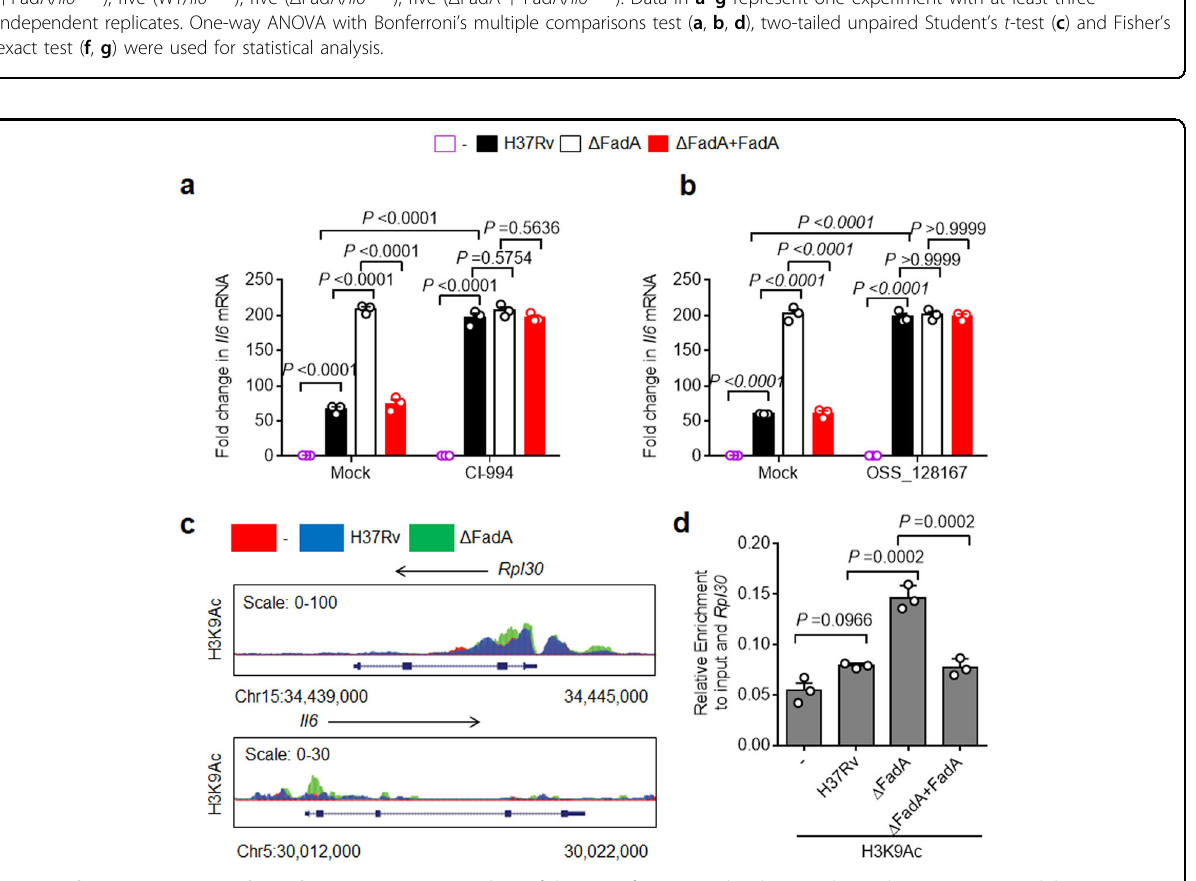
(AcAcCoA) from two molecules of acetyl-CoA 38 (Fig. 5a). To examine the acetyl-CoA acetyltransferase activity of FadA, we expressed FadA as a C-terminally His6-tagged protein from Escherichia coli ( E. coli ) and puri fi ed using immobilized metal ion af fi nity chromatography (Supple- mentary Fig. S9a). The puri fi ed FadA was assayed for